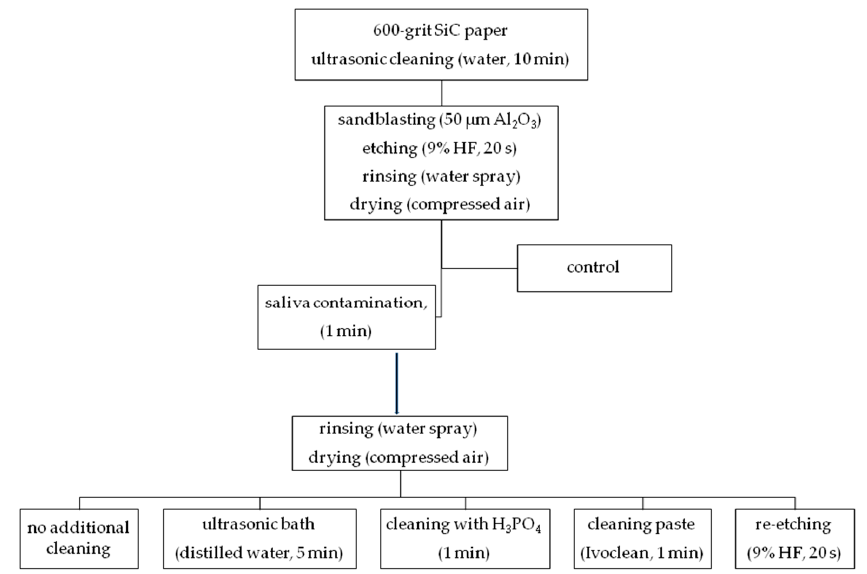
Figure 11. Ceramic surface cleaning methods used in the study (study design).